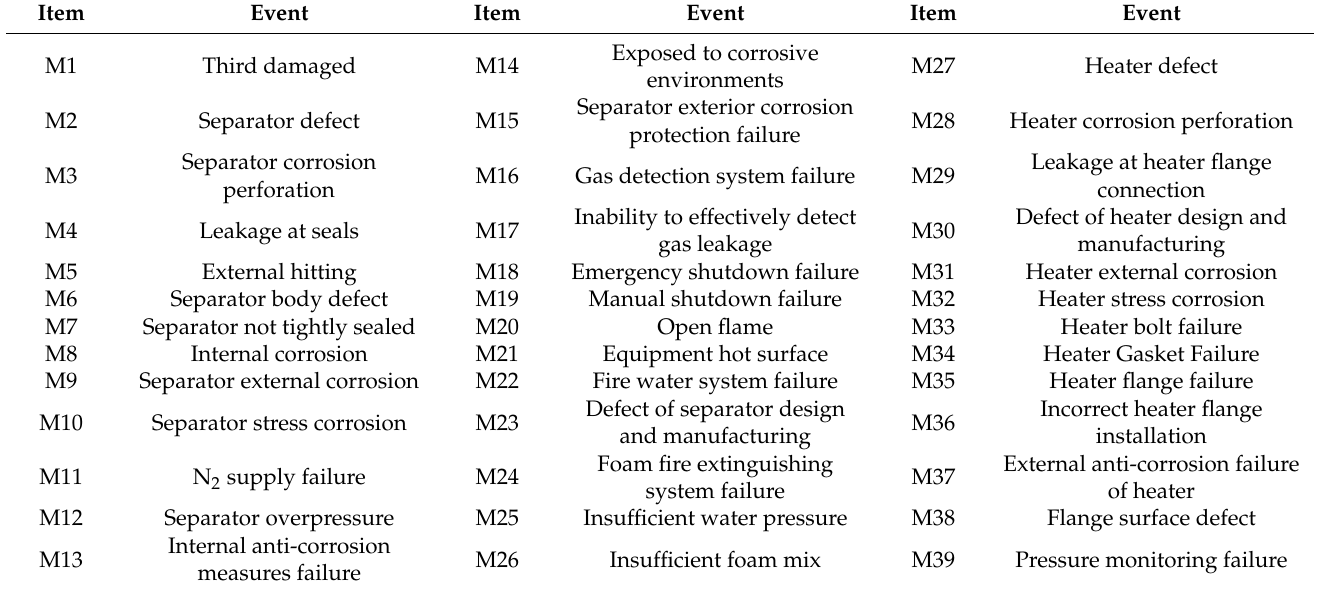
Table 3. Description of the intermediate events.